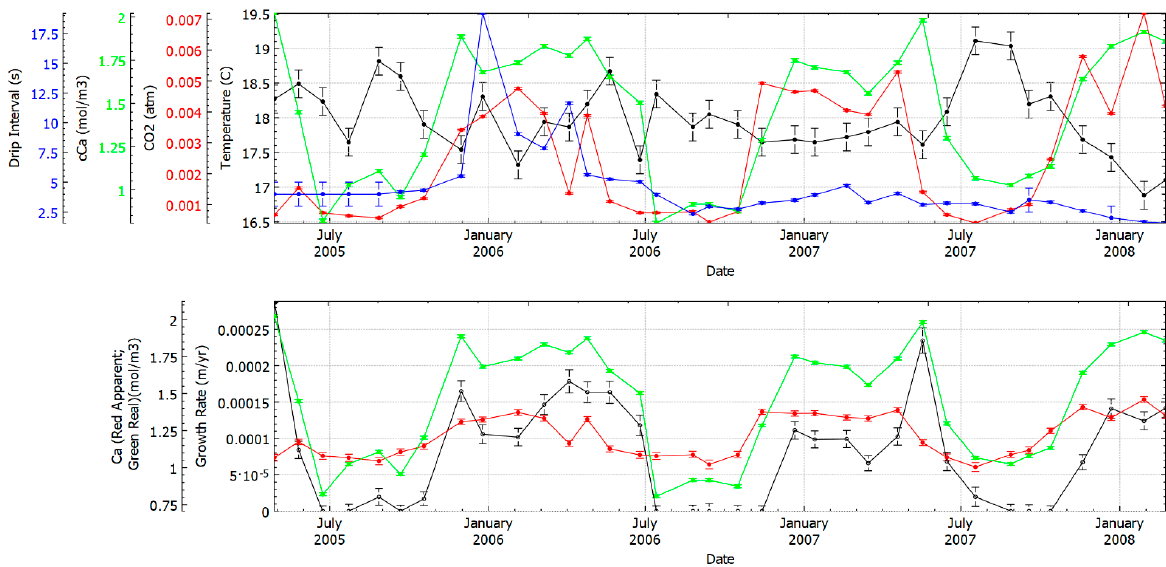
Figure 2. StalGrowth applied to St. Michaels Cave. The top plot shows the input parameters and the bottom plot shows the output of StalGrowth (see Figure 1 for more detail).